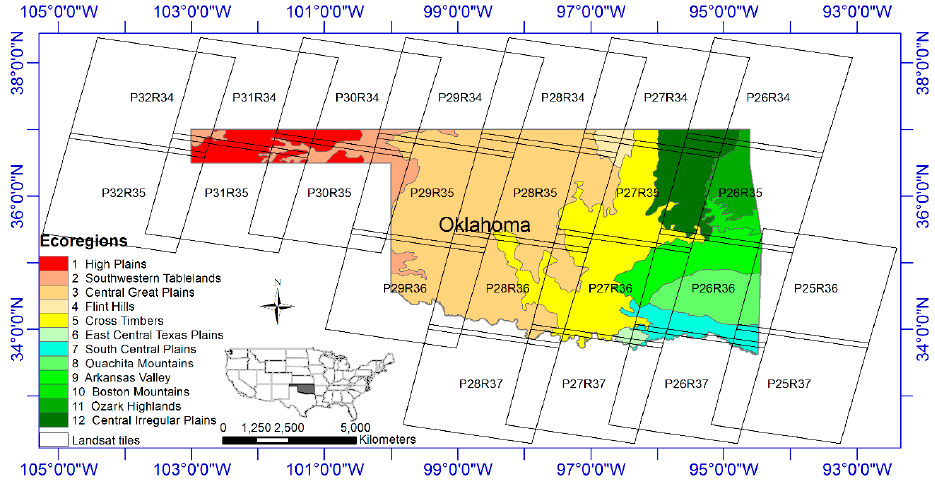
Figure 1. The location of Oklahoma in the United States, as well as the distribution of Landsat tiles and ecoregions in Oklahoma. ecoregions in